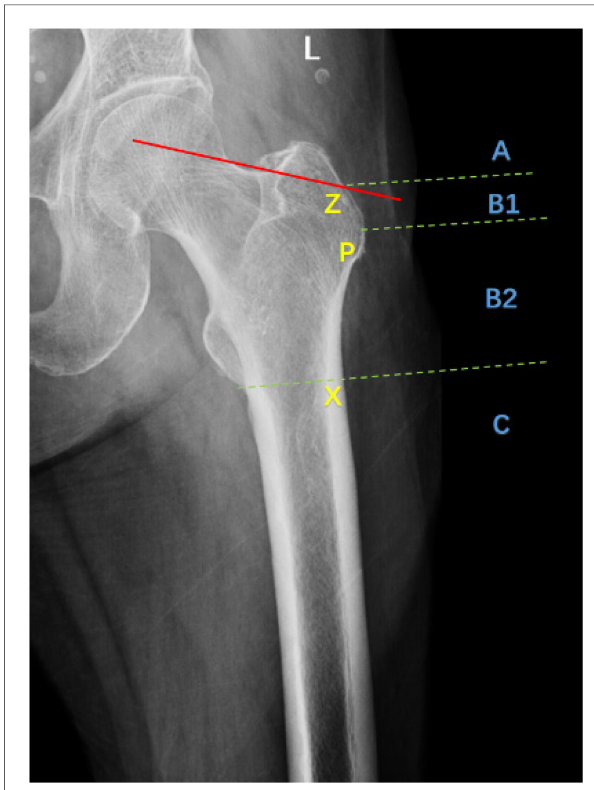
FIGURE 2 Radiograph showing lateral groups. Z: Make a tangent (red line) to the tension trabecular at the superior cortex of the femoral neck. Z is the intersection of the tangent and the lateral femur (16). P represents the vastus ridge that marks the boundary of the cortex (17). X represents the intersection of the vertical line of the lateral femur passing through the lowest point of the less trochanter. The lateral femur is divided into A/B/C region by points Z/X. Ac-cording to the penetration region of the lateral fracture line, the lateral fractures are divided into three groups: A/ B/C. When there are two or more fracture lines, it is group D. Group D can be divided into subgroups by the penetration region of each fracture line, such as D(AC), D(BC), and